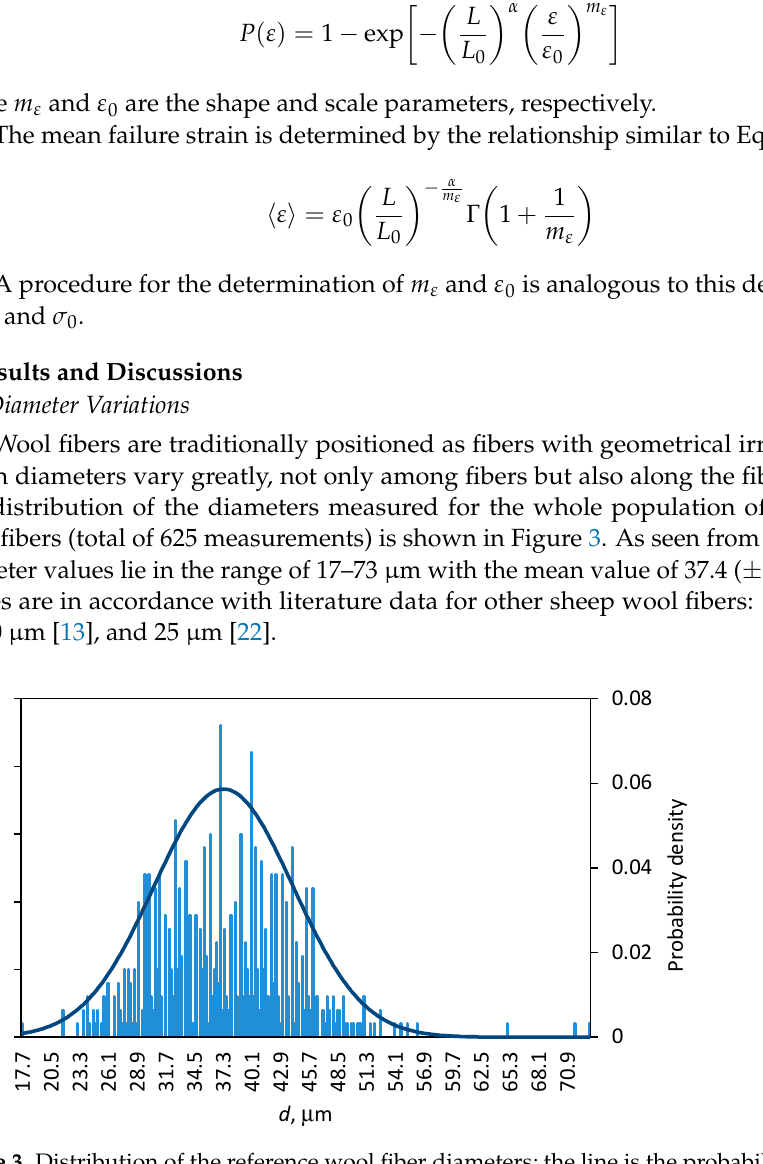
Figure 3. Distribution of the reference wool fiber diameters; the line is the probability density by a normal distribution.